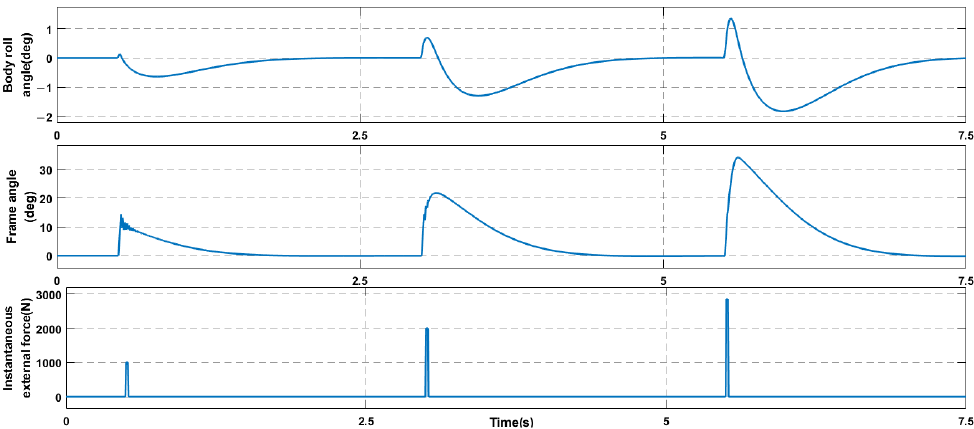
Figure 16. Simulation results: Self-balancing process of the vehicle body under instantaneous shock disturbance.